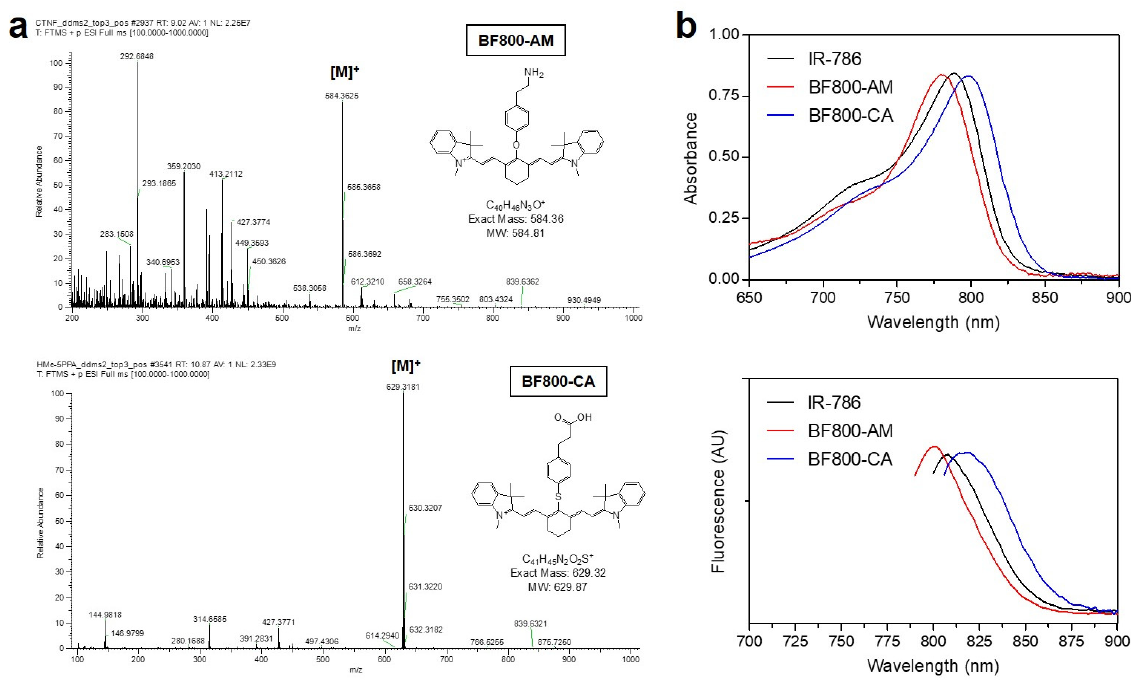
Figure 2. ( a ) Mass spectra of BF800-AM and BF800-CA NIR dyes. ( b ) Absorption spectra and fluorescence emission spectra of IR-786, BF800-AM, and BF800-CA NIR dyes. Optical measurements were performed in PBS at pH 7.4 or 5% BSA saline.